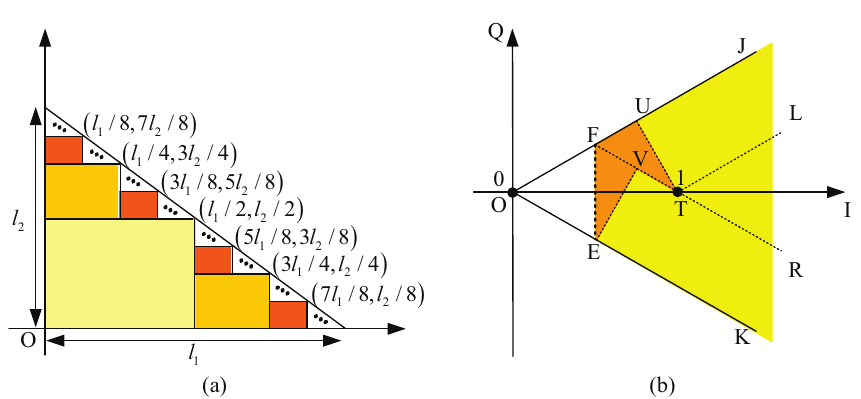
Figure 4. Schematic diagram for division of unconventional regions. ( a ) RT region; ( b ) decision region of signal point